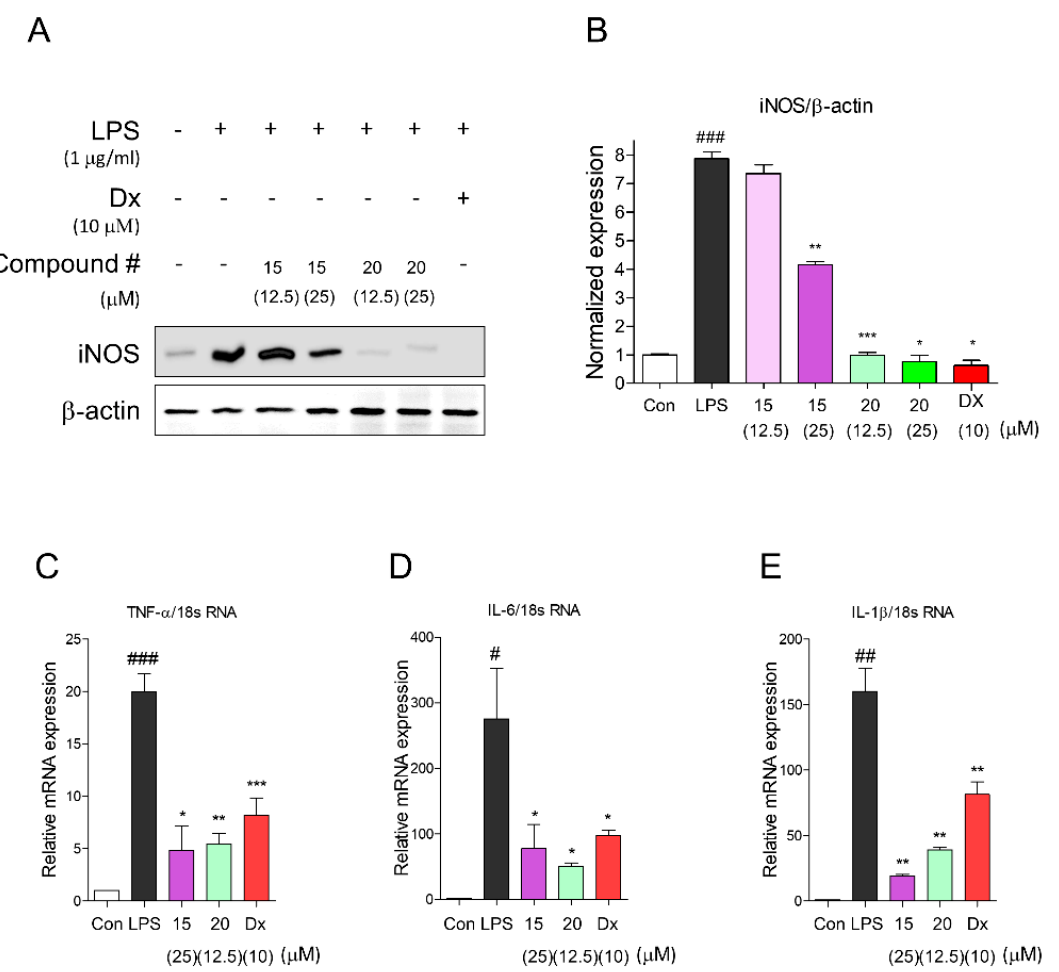
Figure 4. Compound 15 and 20 showed anti-inflammatory effects by inhibiting proinflammatory mediators. ( A ) Compounds 15 and 20 decreased iNOS expression levels in LPS-induced RAW 264.7 cells. ( B ) Relative ratio of iNOS versus β -actin was measured using densitometry, and